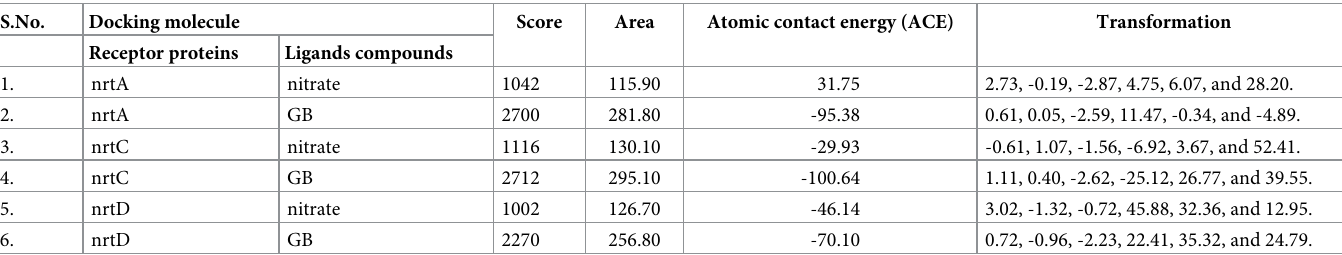
Table 3. PatchDock server molecular docking results of GB and nitrate with ABC transporter proteins nrtACD.